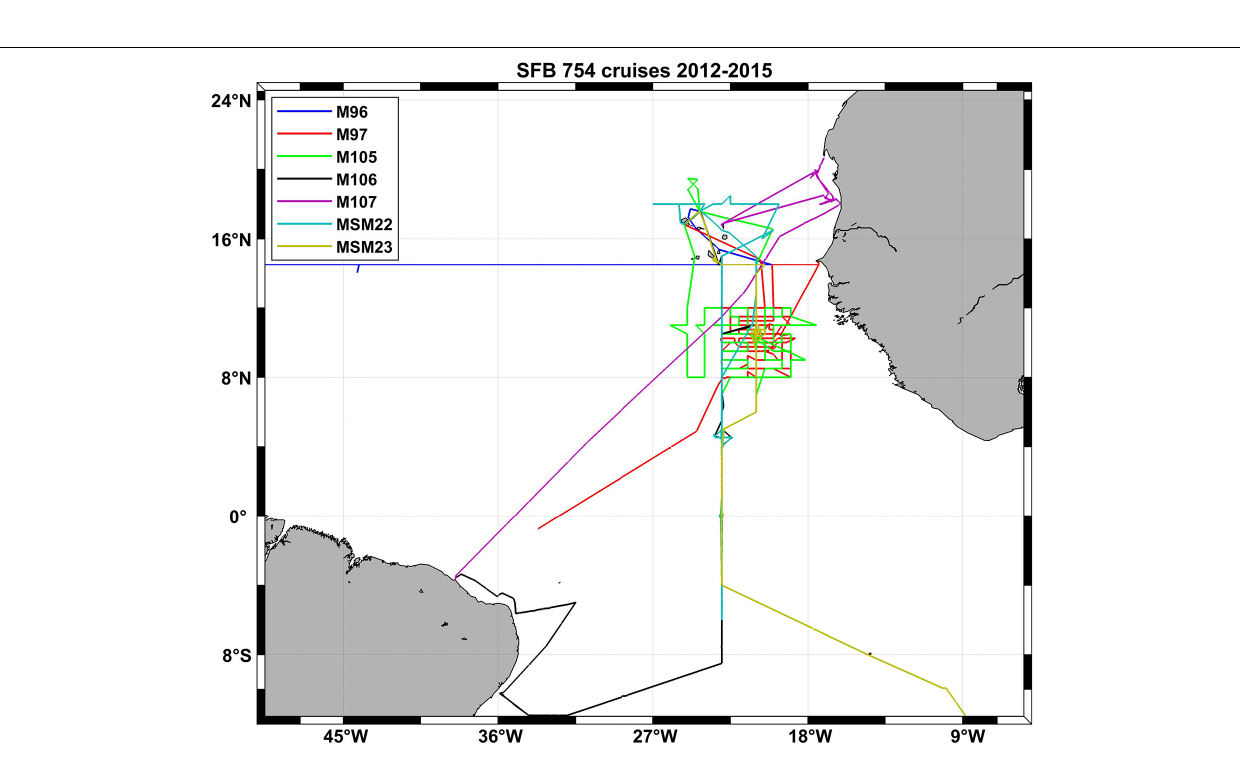
Frontiers in Marine Science |